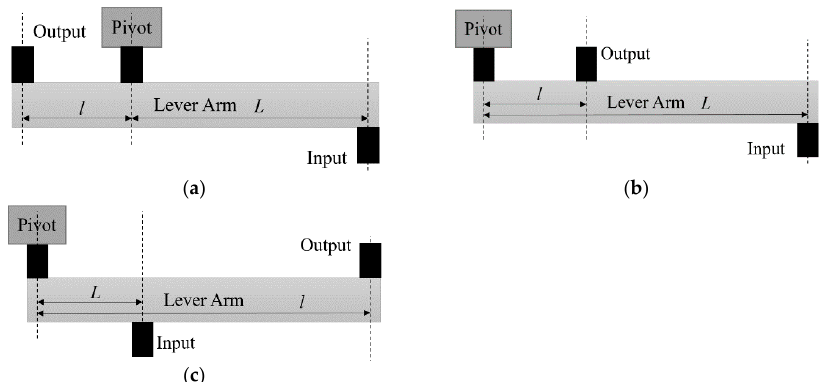
Figure 1. Classification of levers: ( a ) Type I; the pivot location is between input and output. ( b ) Type II; the output location is between pivot and input. ( c ) Type III; the input location is between pivot and